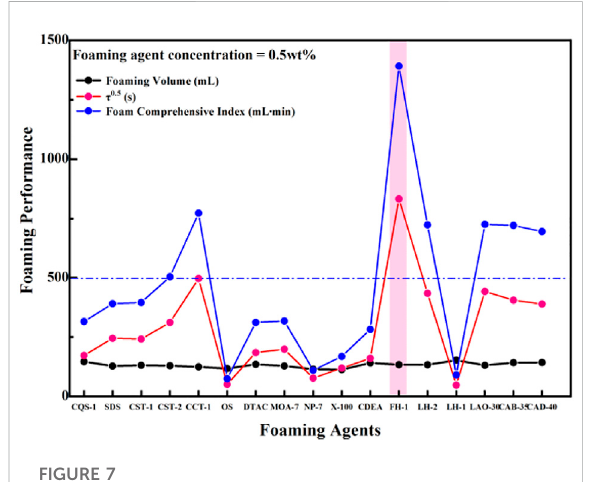
FIGURE 7 Comparison between the foam performance of a 0.5% aqueous solution and a series surface active agent. FIGURE 8